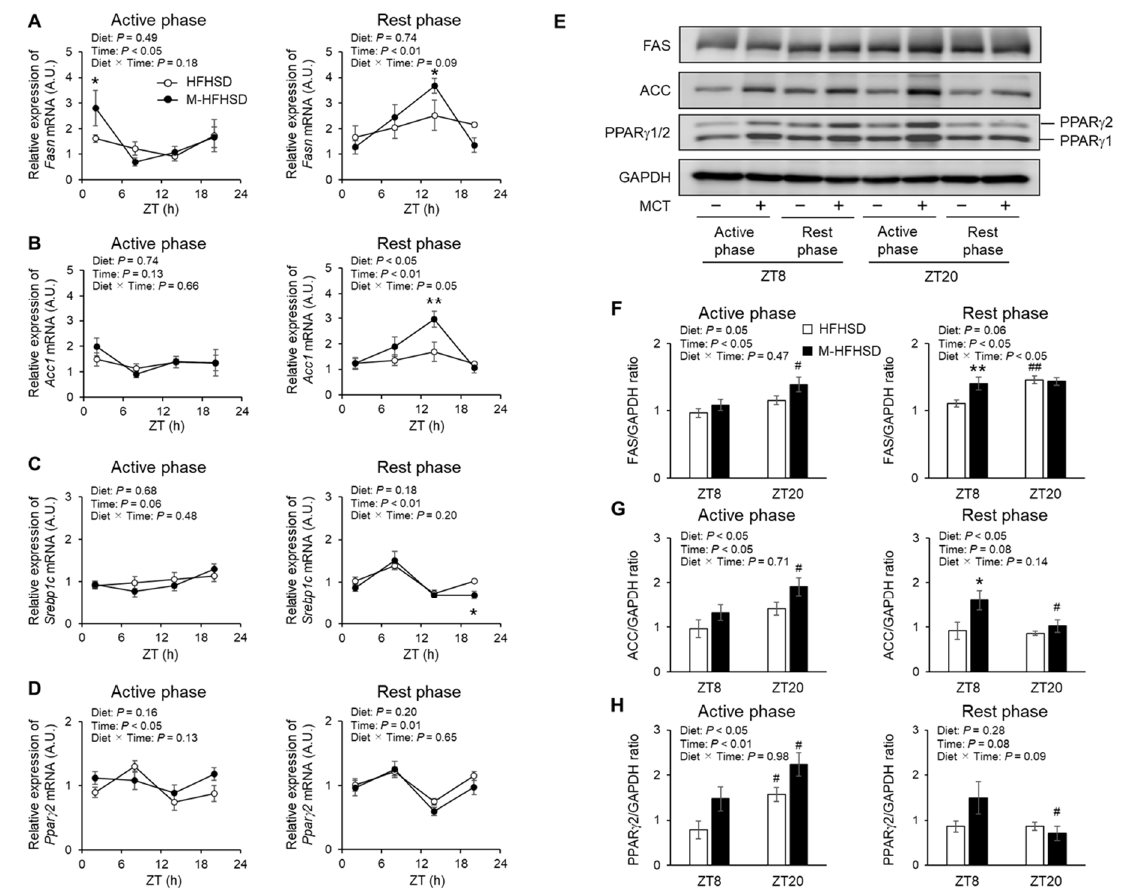
Figure 6. Expression of lipogenic genes and proteins in epididymal WAT. Expression levels of Fasn ( A ), Acc1 ( B ), Srebp1c ( C ), and Ppar γ 2 ( D ) mRNA at indicated times in epididymal WATs of mice. ( E ) Protein expression levels of FAS, ACC, PPAR γ 1/2, and GAPDH in eWAT extracts from mice. ( F – H ) Ratios of FAS-, ACC-, and PPAR γ 2-to-GAPDH. Data are mean ± SEM ( n = 4). * p < 0.05 and ** p < 0.01 vs. HFHSD at same time. # p < 0.05 and ## p < 0.01 vs. same diet at ZT8. WAT, white adipose tissue; eWAT, epididymal white adipose tissue; HFHSD, high-fat high-sucrose diet; MCT, medium-chain triglyceride; M-HFHSD, high-fat high-sucrose diet containing medium-chain triglyceride; ZT, zeitgeber